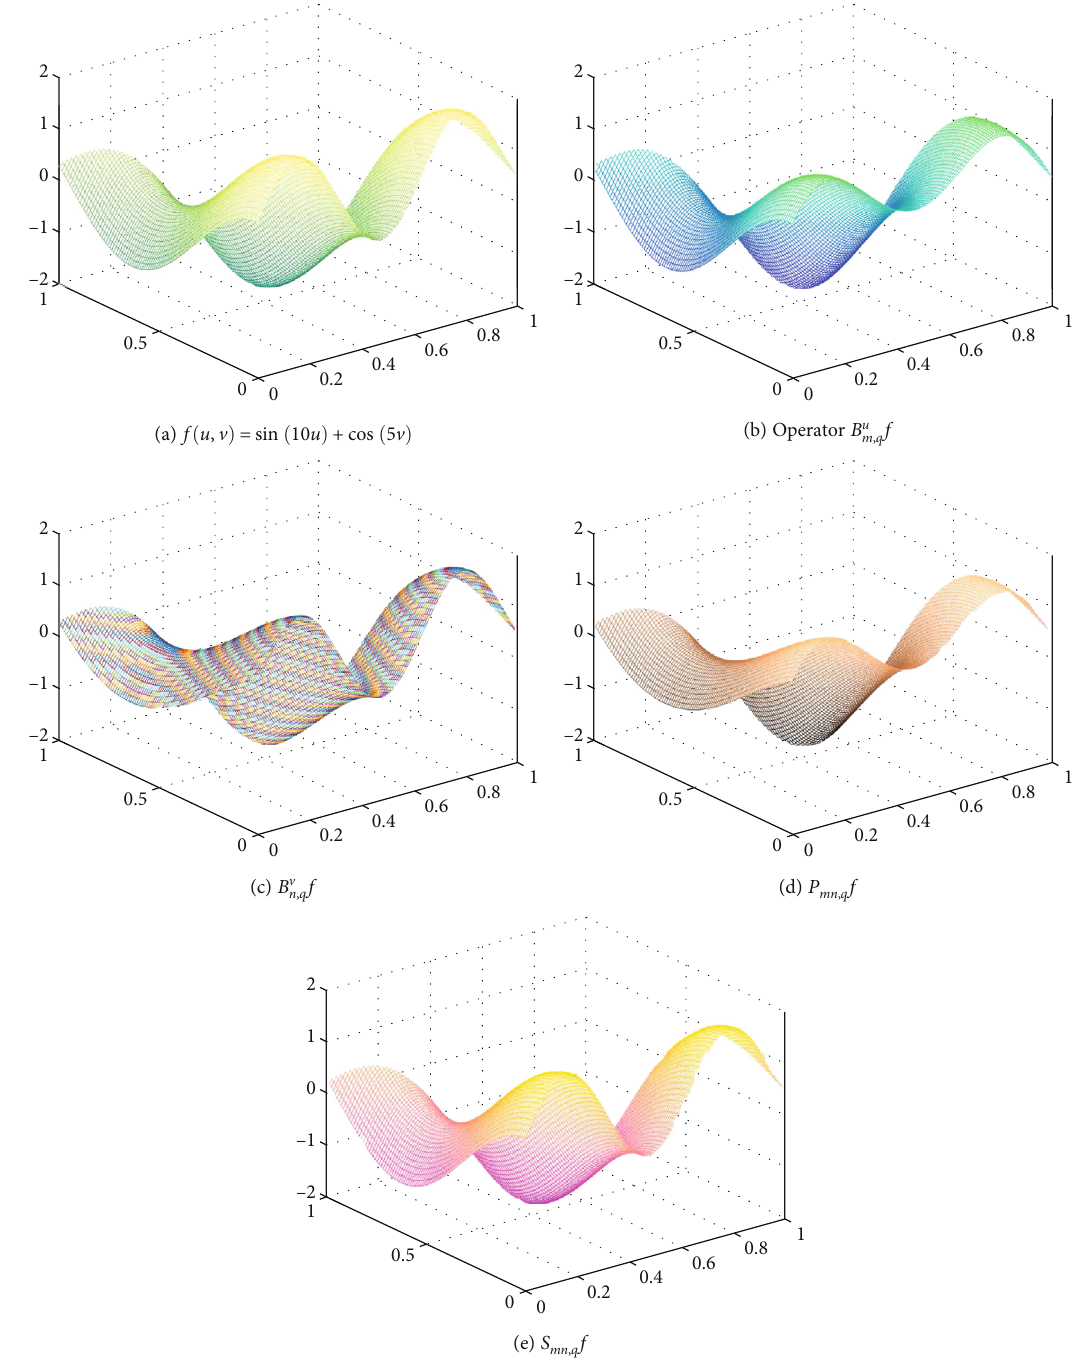
f , B v f , P f , and S f approximating function on triangular domain for h = 1 , m = 15 , n = 10 , and q = 0 : 99 mn , q mn , q m , q n , q